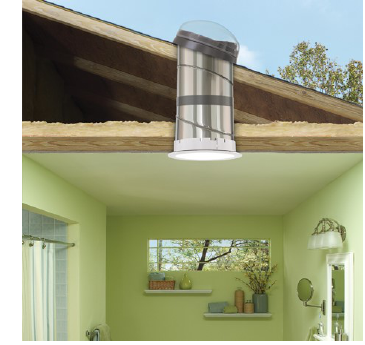
Figure 3. Rigid sun tunnel